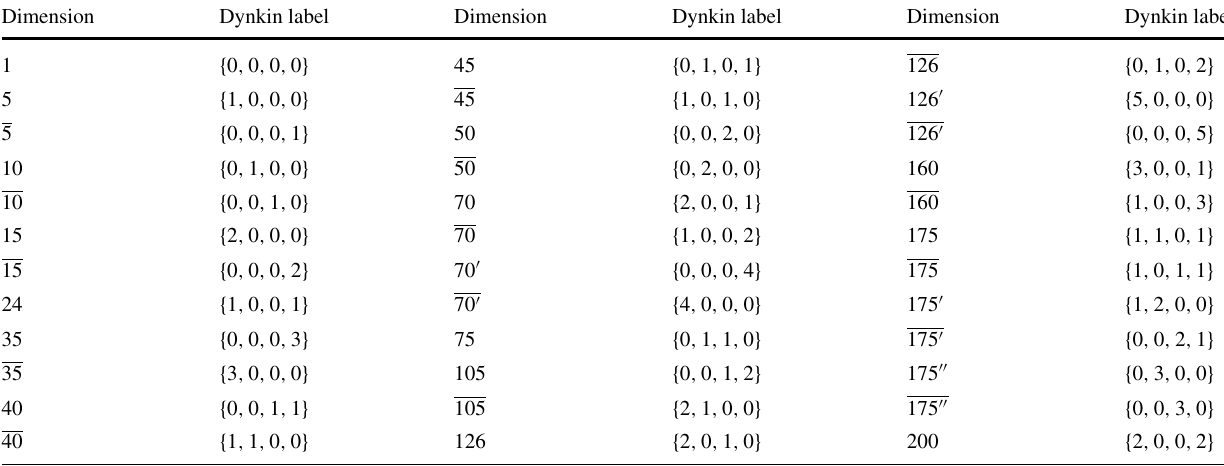
Table 60 Dynkin labels corresponding to a few low dimensional representations of SU ( 5 )